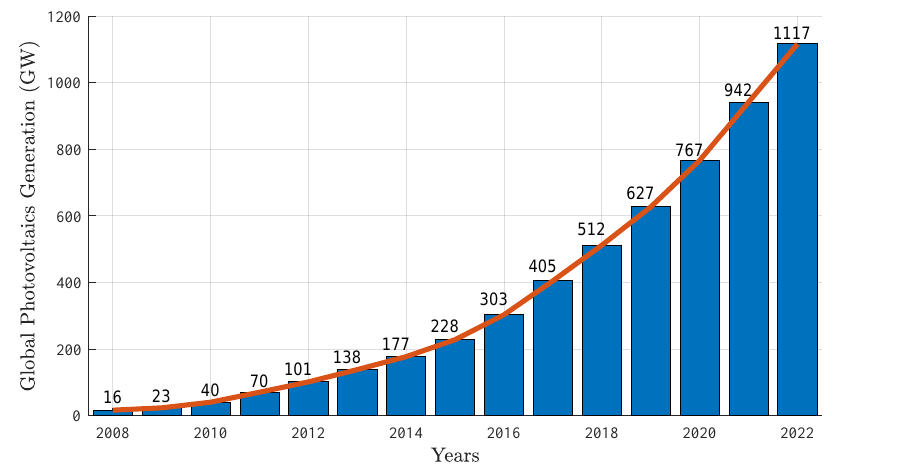
Figure 1. Schematic diagram of the review process.